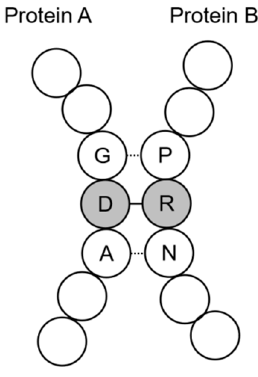
Figure 4. Diagram of interacting residue pairs between two proteins. Two false positive samples (G-P and A-N) caused by strong interaction (D-R). Due to the strong interaction of D and R, the Euclidean distance between G and P or A and N is less than 6.0 Å, but the interaction is dominated by D and R.